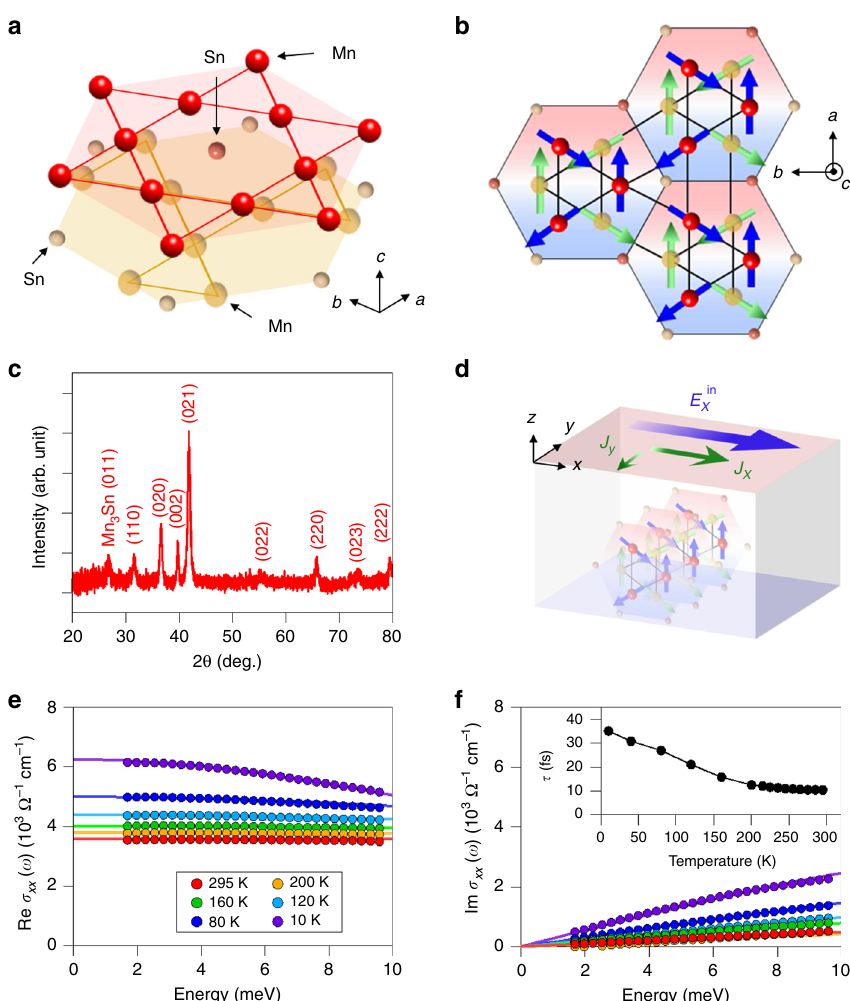
Fig. 1 Crystal and magnetic structures of Mn 3 Sn and the THz longetudinal conductivity spectra. a , b A 3D schematic view of atomic con fi guration ( a ) and top view along c -axis ( b ) of the magnetic structures of Mn 3 Sn at room temperature where the magnetic moments form an inverse triangular spin structure in the ab plane. c The X-ray diffraction measurement for the 50-nm-thick fi lm of Mn 3 + x Sn 1 − x ( x = 0.02) on a SiO 2 substrate. d A schematic of our sample con fi guration. E in x the incident electric fi eld polarized along the x direction, J x the longitudinal current, J y the Hall current. e , f The real and imaginary parts of THz longitudinal conductivity spectra of Mn 3 + x Sn 1 − x thin fi lms ( x = 0.02) on a SiO 2 substrate at various temperatures. The solid curves are the results of the Drude-model fi tting. The inset shows temperature dependence of the scattering time obtained from the fi